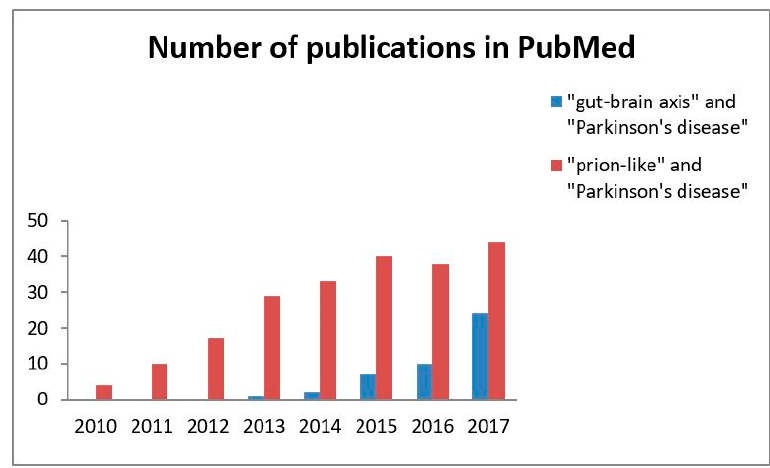
Figure 1. A number of publications on the concept of the gut-brain axis and α -synuclein as a prion-like protein in Parkinson’s disease. The search was performed for each entire year (2010–2017). The values are the crude total number of articles published in English per year according to PubMed.